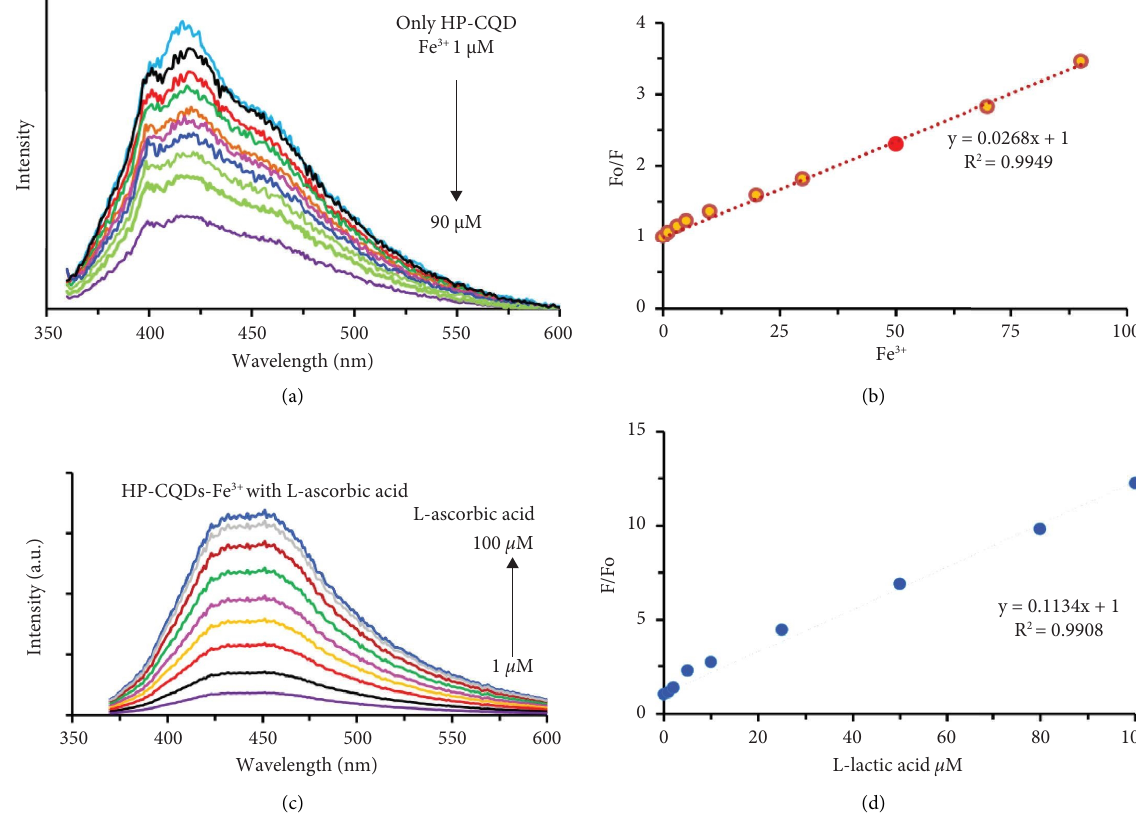
Figure 6: (a) Fluorescence spectra of serial solutions of HP-CQDs: Fe 3+ , the fuorescence spectra were recorded when excited at 350nm. (b) Calibration graph of HP-CQDs: Fe 3+ solutions. (c) Fluorescence spectra of serial solutions of HP-CQDs: Fe 3+ -L-ascorbic acid, and the fuorescence spectra were recorded when excited at 350nm. (d) Calibration graph of HP-CQDs: Fe 3+ -L-ascorbic acid solutions.